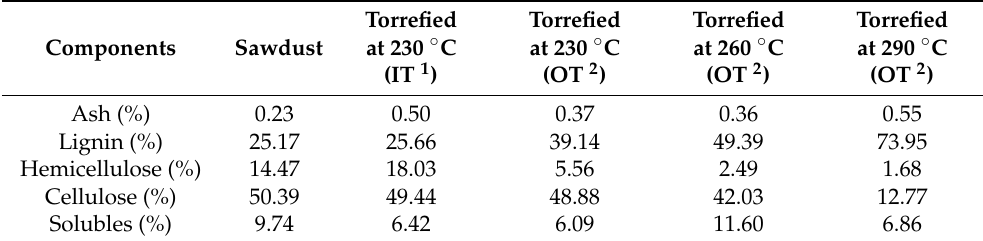
Table 4. Chemical composition of torrefied and raw